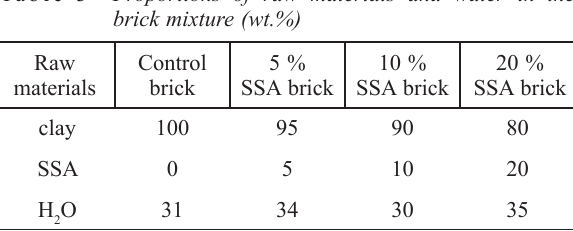
Table 4 – Composition of